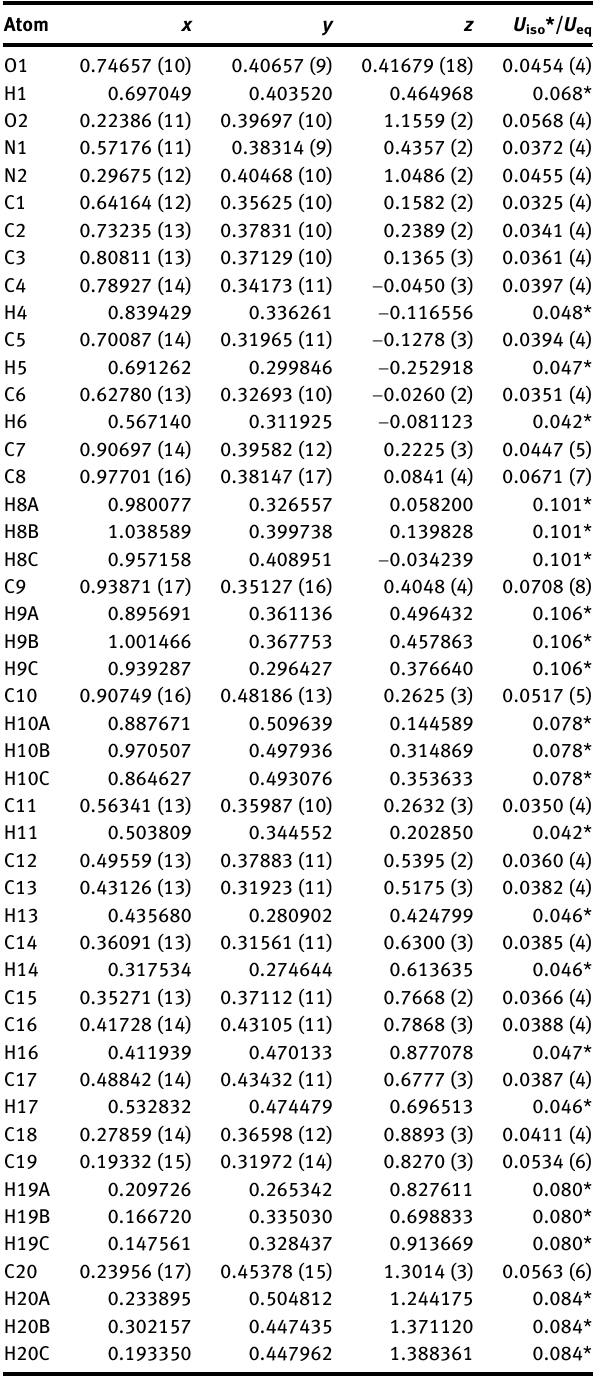
Table  : Fractional atomic coordinates and isotropic or equivalent isotropic displacement parameters (Å 